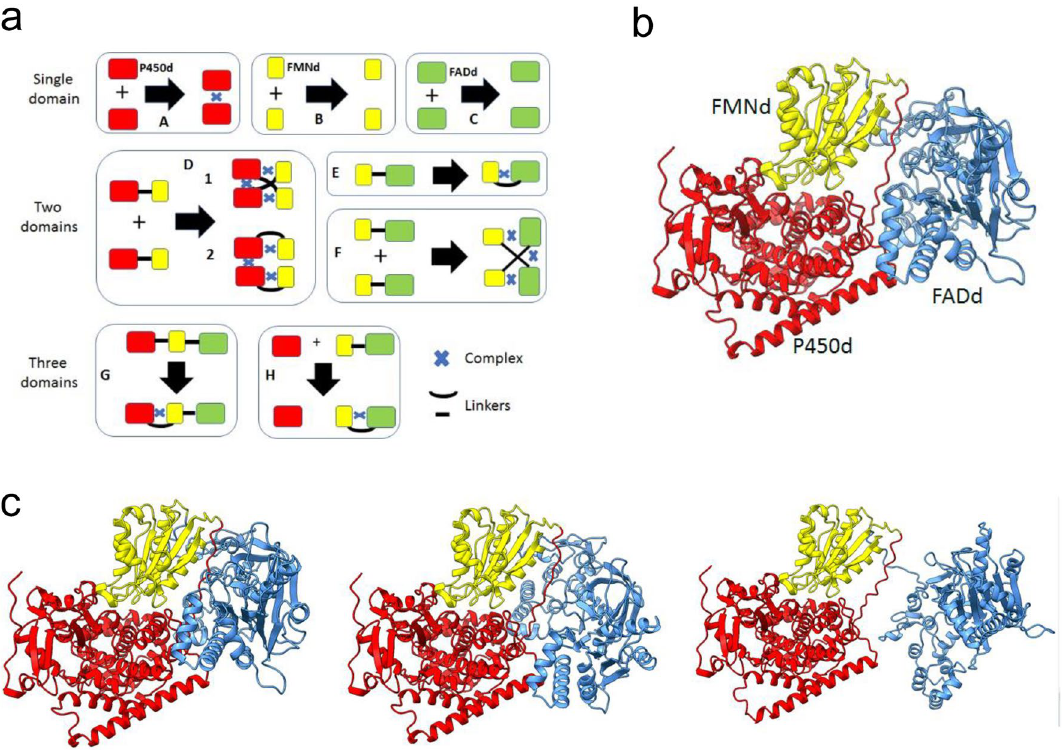
Figure 1. Modeling of CYP102A1 monomer and of partial structures. ( a ), Partial models considered for the assembly of the full-length CYP102A1 dimer structure. P450d, FMNd and FADd are represented as red, yellow and green boxes, respectively. Polypeptide chain linkers are indicated by solid lines and the AF2A-predicted complex formations with a blue cross. ( b ), Model for CYP102A1 monomer released in AlphaFold